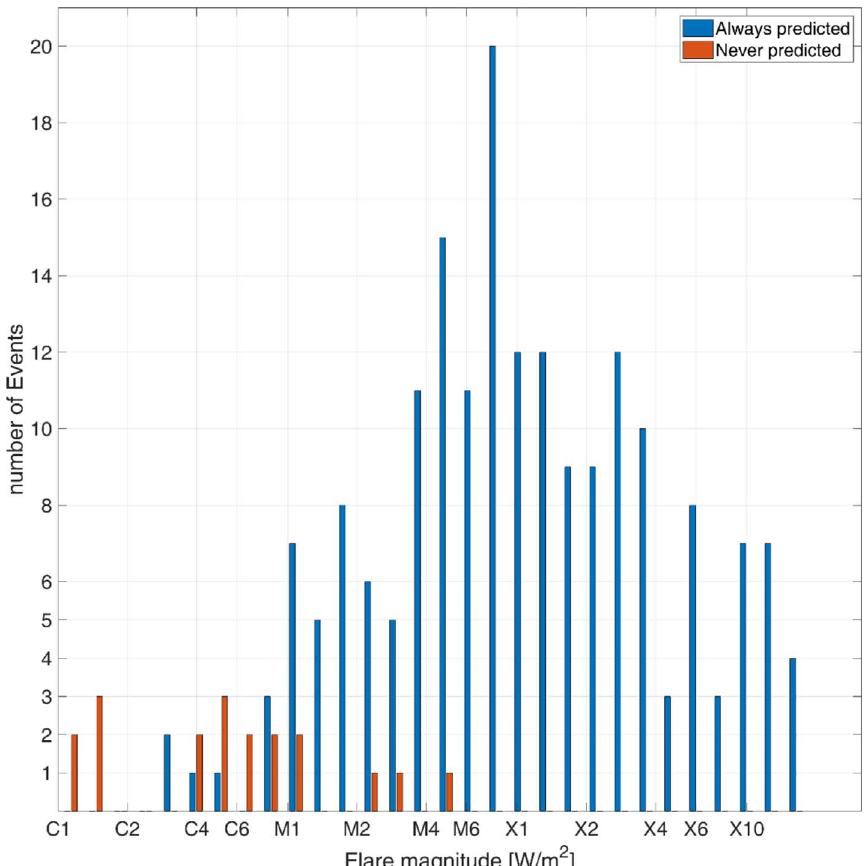
Fig. 9. The number of events in 30 logarithmic bins of the magnitude of their associated SFs. The NP events mainly occupy the lower end of the fl are